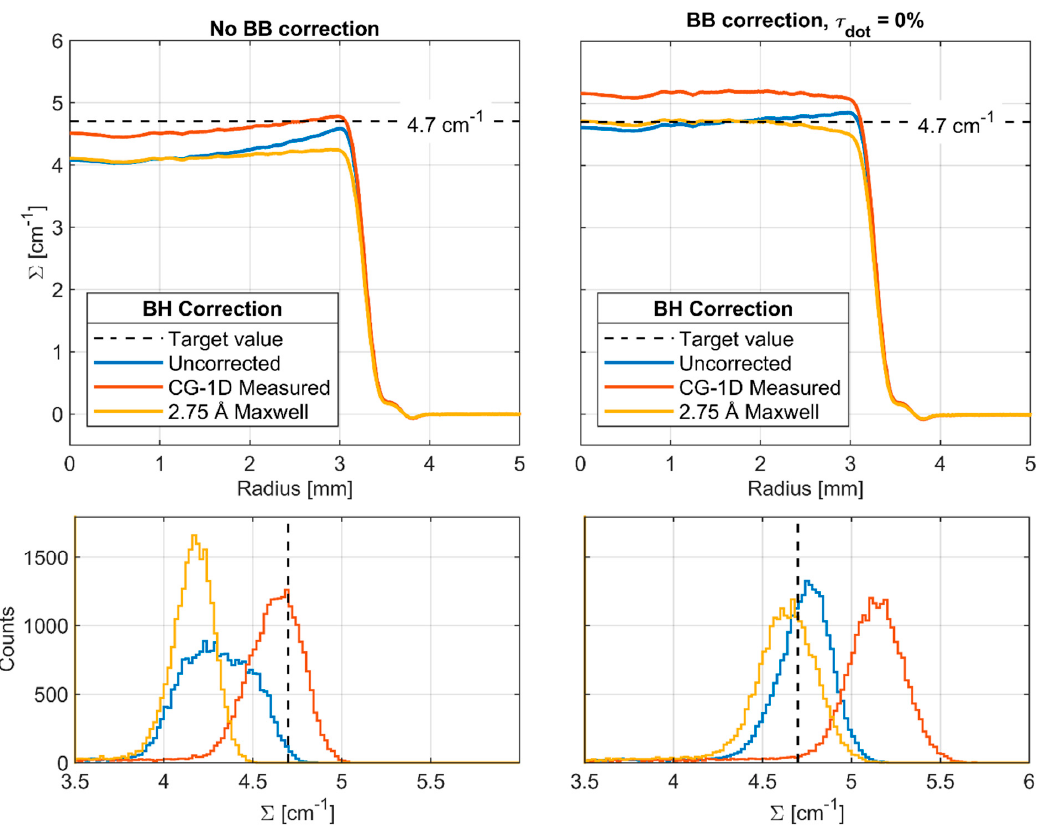
middle at those angles. Conversely, at the projection angles between roughly 120° and 300°, there is a BB within the column but none at the edge, and the scattering at the edges is thereby overestimated. This results in an inhomogeneity in the scattered fraction sinogram. Figure 17. Water column CT radial profiles and histograms with BB and BH corrections.